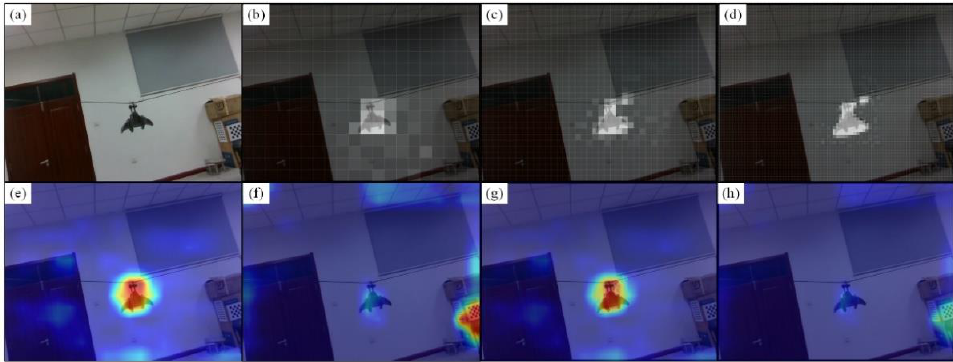
Figure 15. Visualization of feature maps and depth-attention matrices. ( a ) Input image of the test dataset. Depth-attention matrix, g ( x ), on the feature map of the last layer: ( b ) g ( x ) of large target recognition, ( c ) g ( x ) of medium target recognition, ( d ) g ( x ) of small target recognition. Feature heat map of the last layer at the standard YOLOv5 inference: ( e ) correct inference, ( f ) false inference. Feature heat map of the last layer at the depth-attention YOLOv5 inference: ( g ) correct inference, ( h ) false inference.